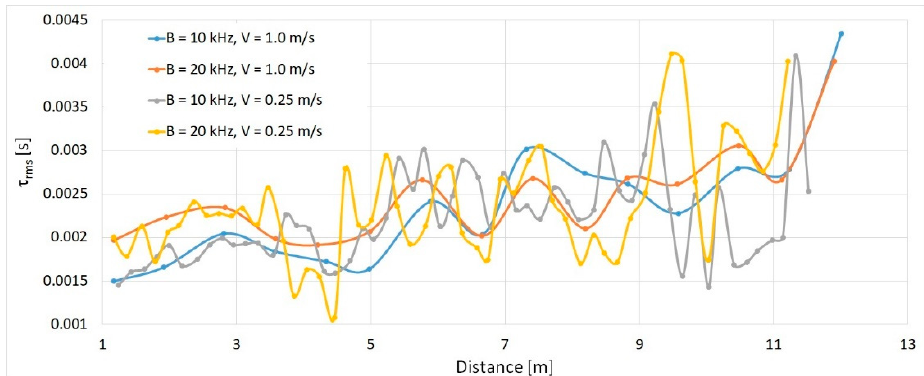
Figure 13. Influence of the distance from the receiver on the delay spread for chirps with a center frequency of F C = 60 kHz, a duration of T = 30 ms, and different bandwidths, B , for transmitter velocities of 𝑉 = 1 m/s and 𝑉 = 0.25 m/s .